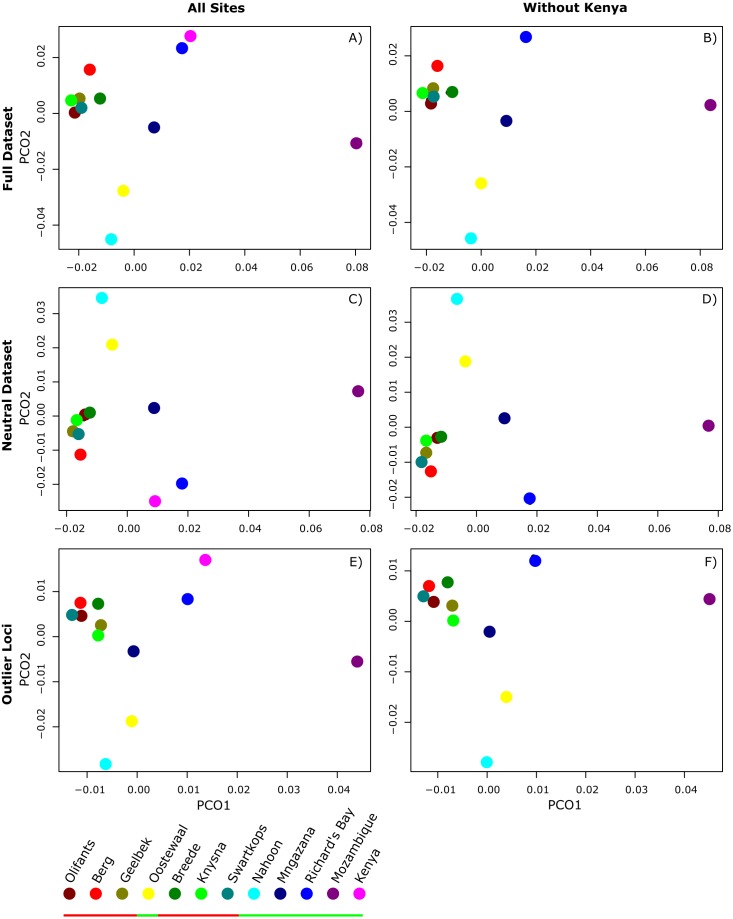
Principle Coordinate Analysis (PCoA) plots of average pairwise FST comparisons among all 12 sampling sites (A, C, E) and all sites excluding Kenya (B, D, F) for all loci in the complete dataset (A, B), the subset of loci contained in the simulated neutral dataset (C, D), and outlier loci (E, F). Sites grouping with cluster one and two are indicated by the red and green bar in the legend, respectively.